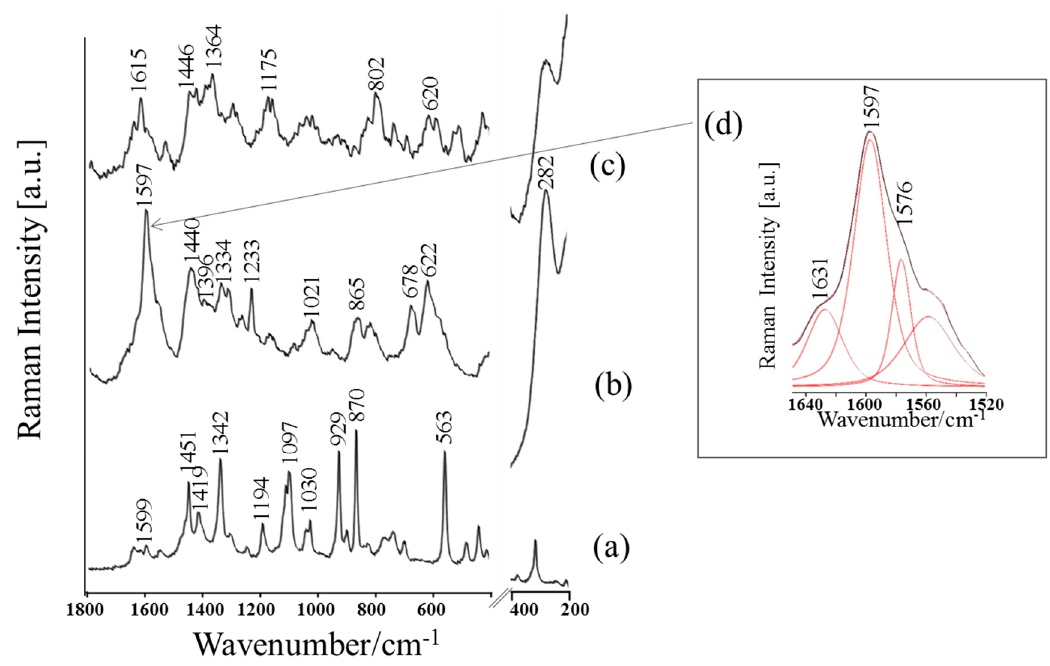
Figure 3. ( a ) RS spectrum of Thr (10 − 1 M / 0.5 M HCl); ( b ) SERS spectra of Thr (10 − 1 M); and ( c ) Thr (10 − 3 M) adsorbed onto the corroded CuNPs-Fe surface. Measurement conditions: spectral range, 1800–200 cm − 1 ; laser line, 632.8nm. ( d ) Inset: the deconvolution SERS spectrum; spectral range, 1650–1520 cm − 1 .